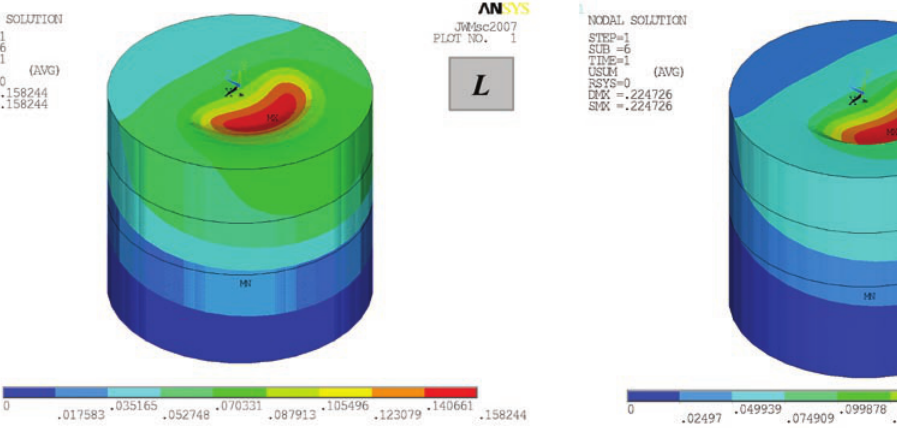
Fig. 7. Foundation settlements s L ∈ [0; 0.158], m Fig. 7a. Foundation settlements s NL ∈ [0; 0.225], m